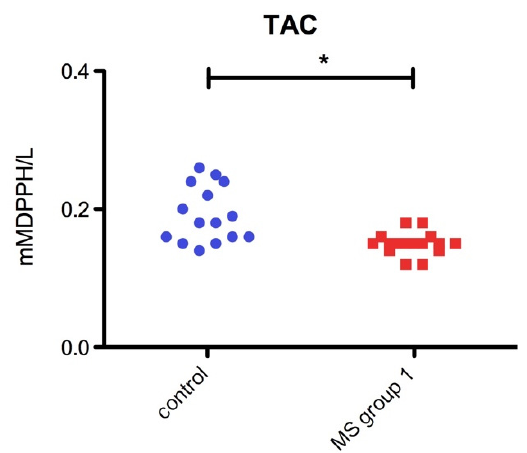
Figure 3. Bar plot (mean with SEM) of plasmatic TAC level in Control group and RRMS group ( p = 0.04*).